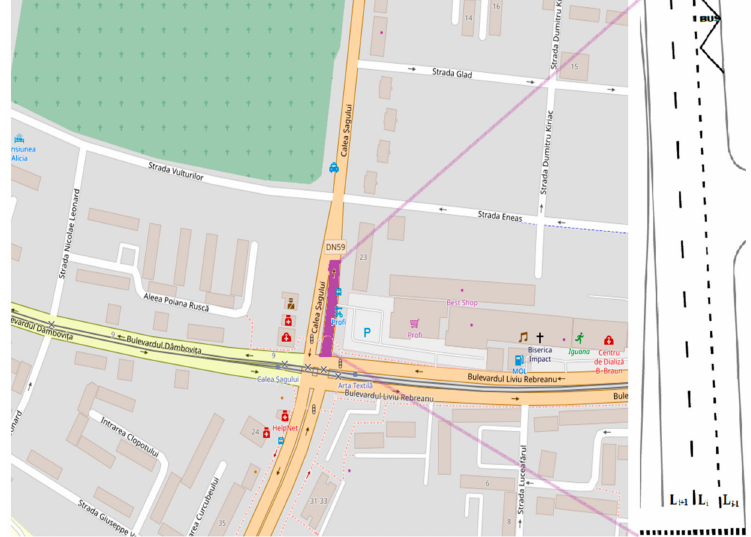
Figure 5. Case study—a section of three-lane road in Calea Sagului, Timisoara, Romania (Source of the map: OpenStreet Maps ).